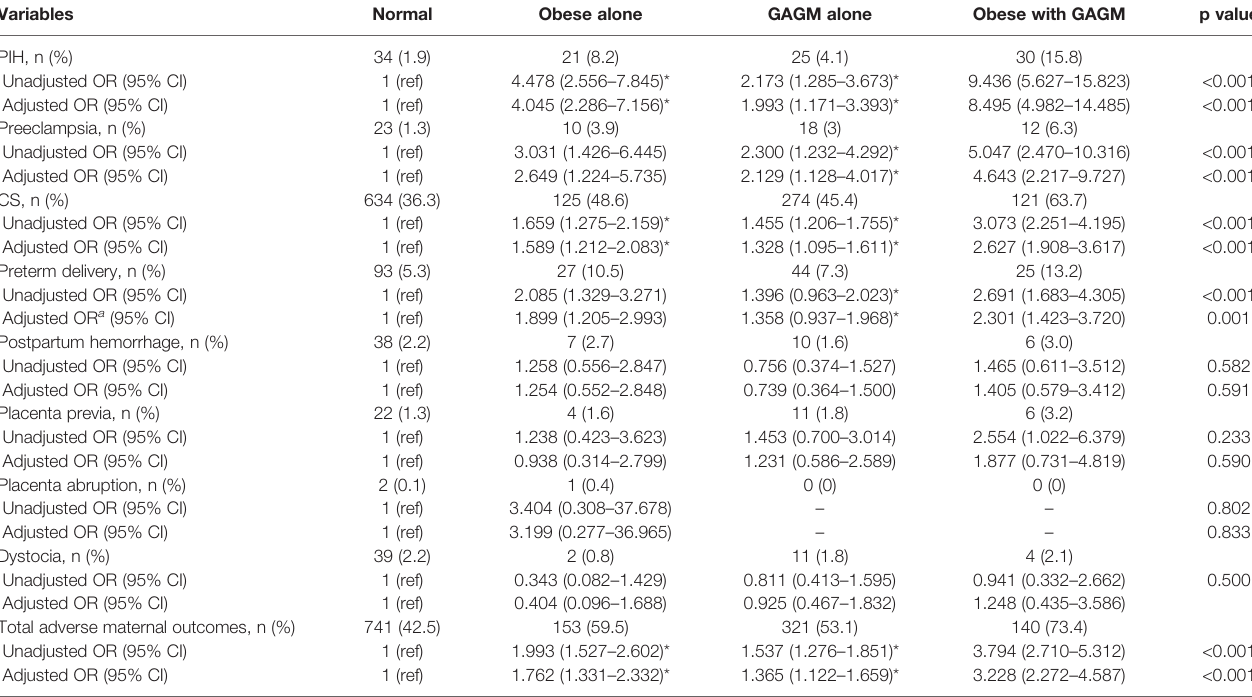
TABLE 2 | Association of maternal pre-pregnancy obesity and GAGM and adverse maternal outcomes. Variables Normal Obese alone GAGM alone Obese with GAGM p value